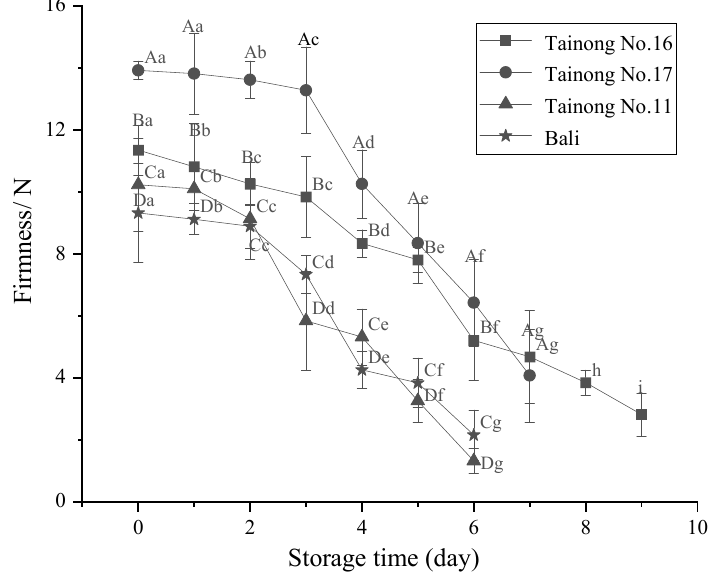
Figure 3. Changes in firmness in freshly cut pineapple during storage. Different capital letters (A–D) indicate significant ( p < 0.05) differences in firmness between varieties at the same storage time; different lowercase letters (a–i) indicate significant ( p < 0.05) differences in firmness between the same varieties at different storage times.